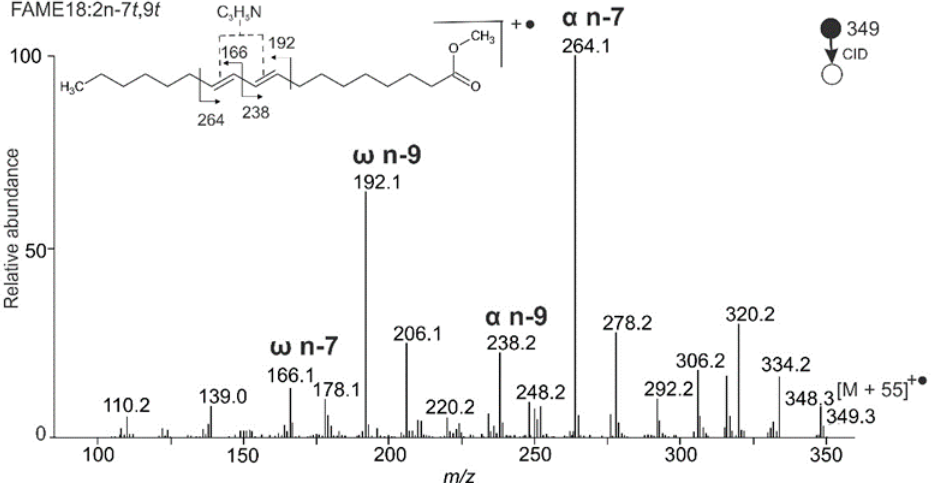
Figure 1. APCI MS/MS CID spectrum of [M + 55] + • adduct of Mangold’s acid methyl ester (FAME 18:2n-7 t ,9 t ); MBR = 264 + 192 − 349 = 107.